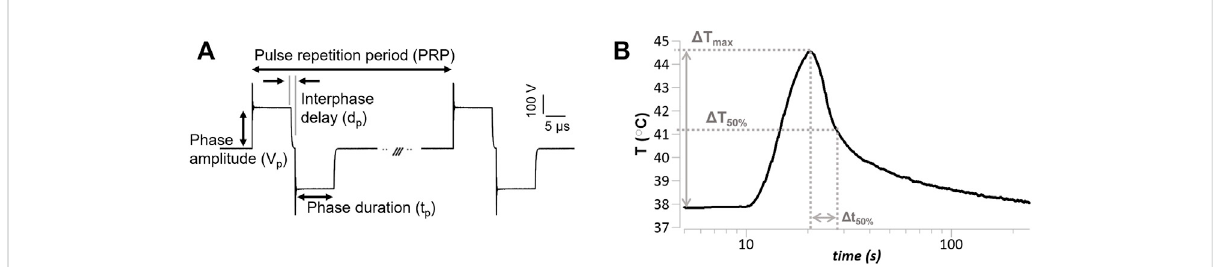
Pulsed electric fi eld (PEF) pulse parameters and temperature endpoints (A) Representative voltage waveform (V p = 236 V, t p = 10 µs, d p = 1 µs, PRP = .1 s), and relevant PEF parameters de fi nition. The pulse repetition period is the inverse of the pulse repetition frequency reported in the text. The voltage amplitude overshoot was 20% – 60% of the phase amplitude. (B) Representative temperature measure in response to a PEF treatment (V